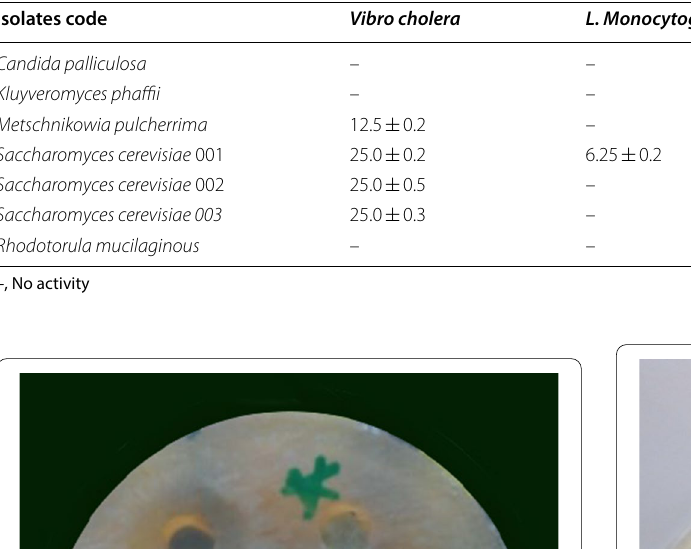
Table 10 Minimum bactericidal concentration (μg/ml) of yeast supernatant against test bacteria